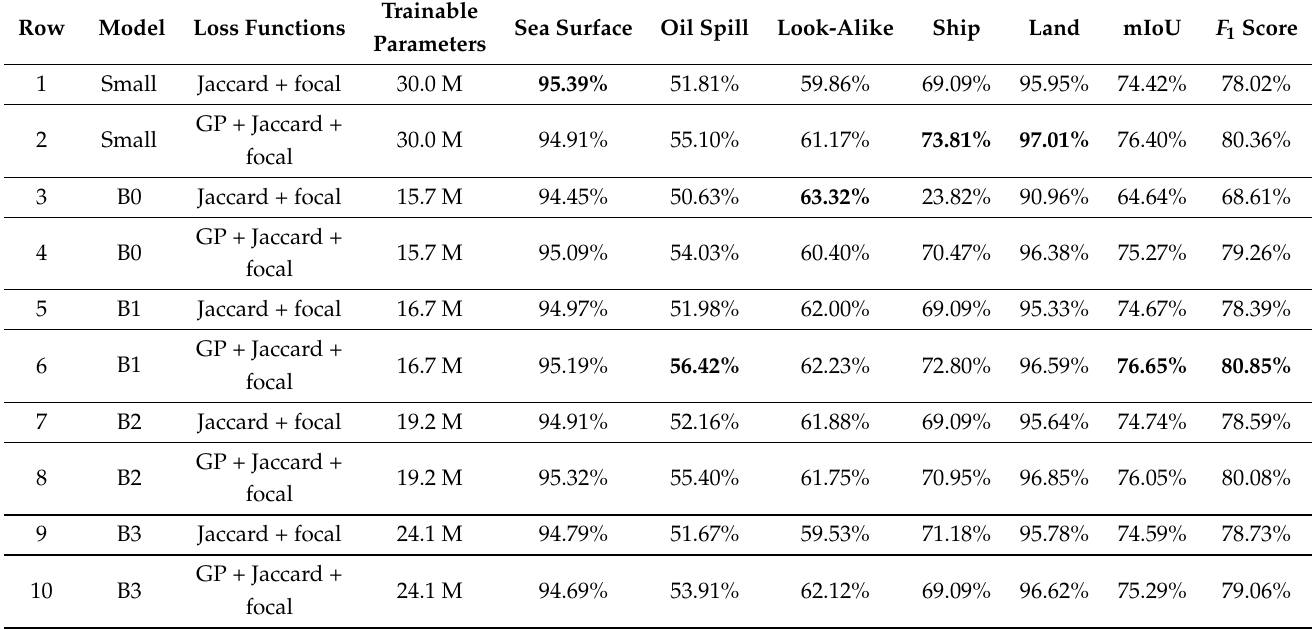
Table 4. Ablation on different variants of EfficientNetV2 CNNs and different loss functions, evaluated over the test SAR images in terms of the IoU and F 1